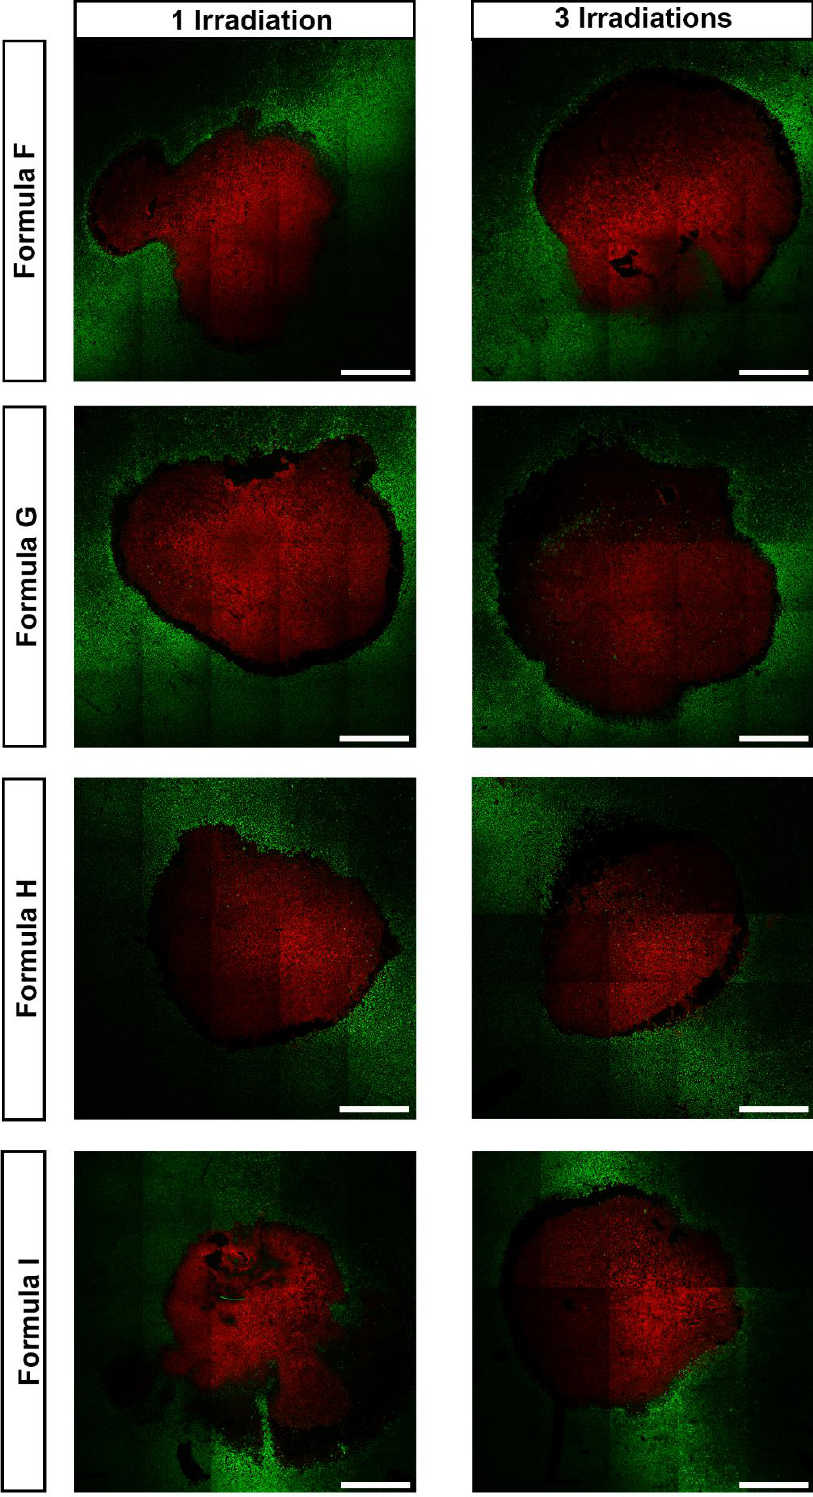
Figure 6. Cytotoxic effect of AuMSS nanoformulations in HeLa cells. Live/Dead CLSM images of the cytotoxic activity of different nanoclusters at 200 µg/mL with 1 and 3 laser irradiations. Green Channel: Calcein stained cells; Red channel: PI-stained cells. Scale bar: 200 μm.